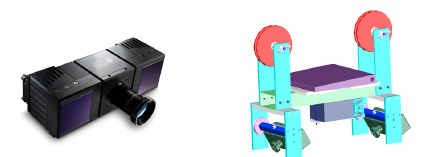
Figure 3: PMD[vision] CamCube 2.0 and model of a cable car equipped with two range imaging devices.